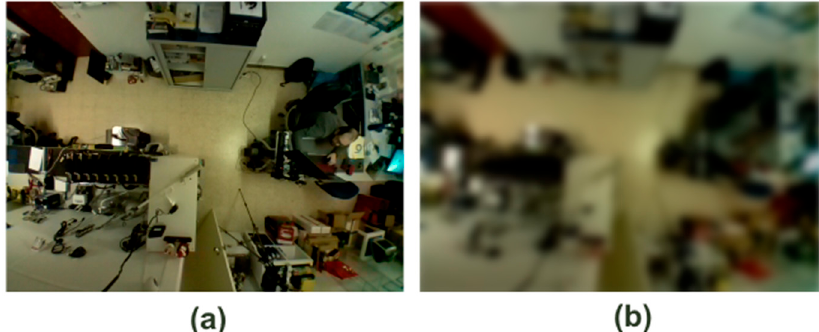
Figure 5. Focused ( a ) and unfocused ( b ) lens.